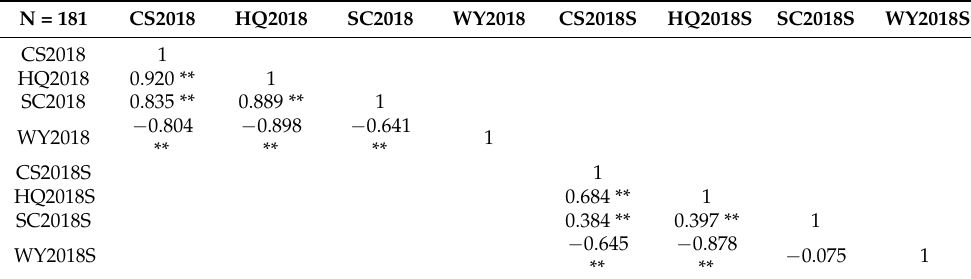
Table 4. Pearson’s correlation analysis between changes in ecosystem services.